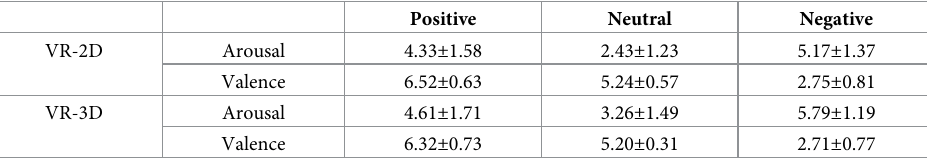
Table 2. The average value (mean ± S.D.) of valence and arousal in SAM (38